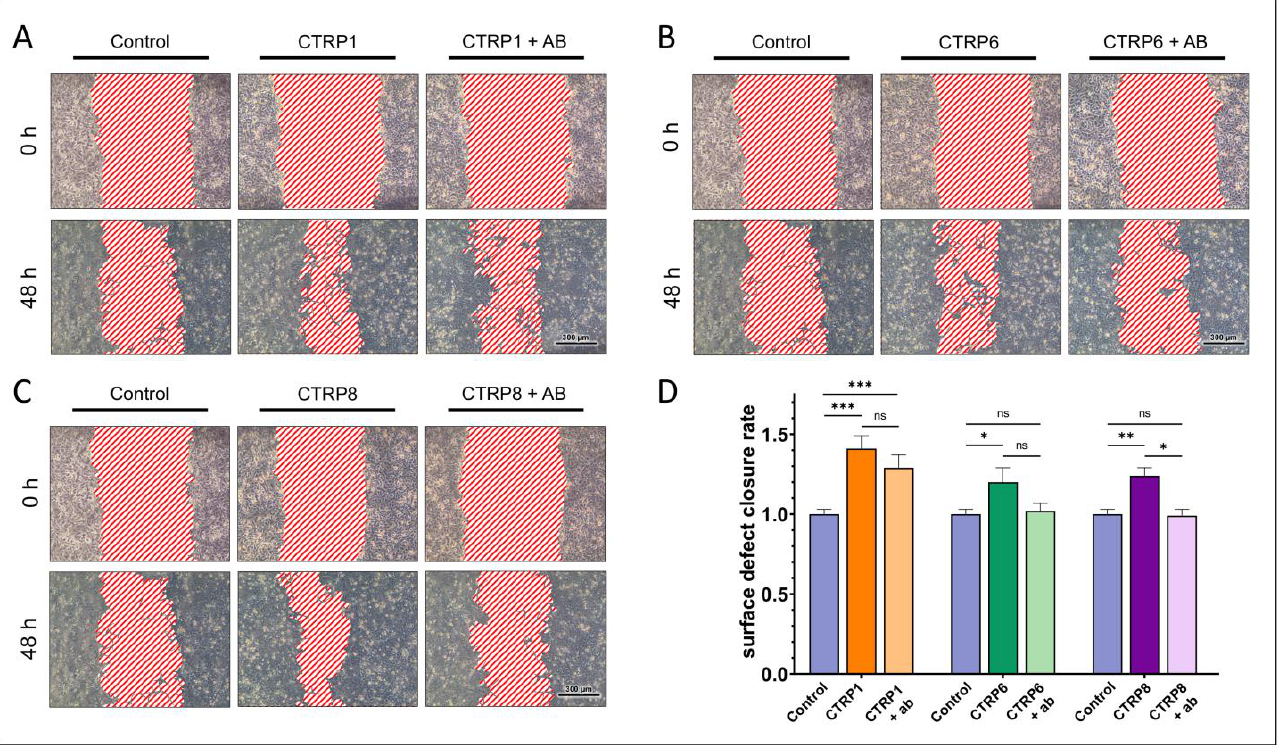
Figure 9. Scratch assays show the dependence of CTRP1, CTRP6, and CTRP8 effects on the RXFP1 receptor pathway. ( A – C ) show representative scratch assays in human corneal epithelial cells (HCE). Cells were stimulated with 100 ng/mL CTRP1 ( A ), CTRP6 ( B ), or CTRP8 ( C ) for 48 h with or without the presence of 3 mg/mL of a specific inhibitory anti-RXFP1 antibody (ab). The surface defect was measured in a representative segment of a scratch ( n ≥ 9) at different time points and compared to untreated HCE cells (control). ( D ) Fold-increase in the surface defect closure rate. Bars represent mean ± SEM. All three tested peptides significantly increased the surface defect closure rate compared to the untreated control (one-way ANOVA; * p < 0.05; ** p < 0.01; *** p < 0.001). The presence of the inhibitory anti-RXFP1 antibody significantly reduced the effect of CTRP8 on the surface defect closure rate (one-way ANOVA; * p < 0.05). There were no significant differences in the surface defect closure rate between the untreated control and HCE that were treated with CTRP8 but also underwent RXFP1 inhibition (one-way ANOVA; ns = not significant, p > 0.05). Inhibition of RXFP1 decreased the surface defect closure rate in CTRP6-treated HCE, but not significantly (one-way ANOVA; ns, p > 0.05). However, there was also no significant difference in the closure rate of HCE simultaneously treated with CTRP6 and the anti-RXFP1 antibody compared to the untreated control (one-way ANOVA; ns, p > 0.05). CTRP1 effects on the surface defect closure rate in HCE were barely affected by RXFP1 inhibition (one-way ANOVA; ns = not significant, p > 0.05) and stayed significantly increased compared to the control (one-way ANOVA; * p < 0.05; ** p < 0.01; *** p < 0.001).